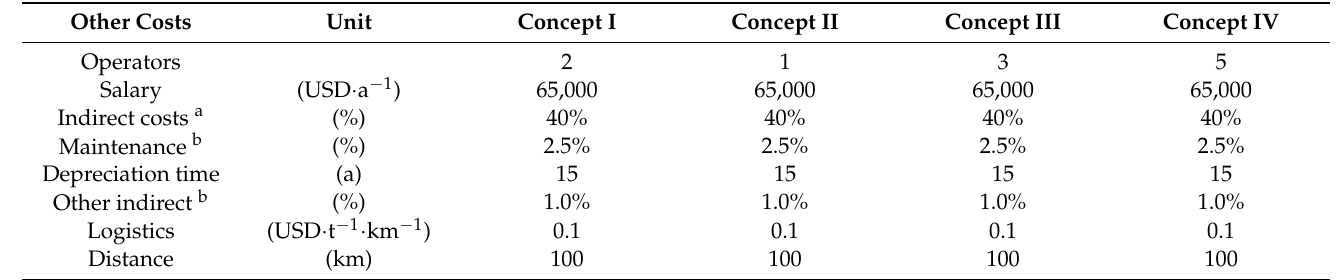
Table 6. Other costs.